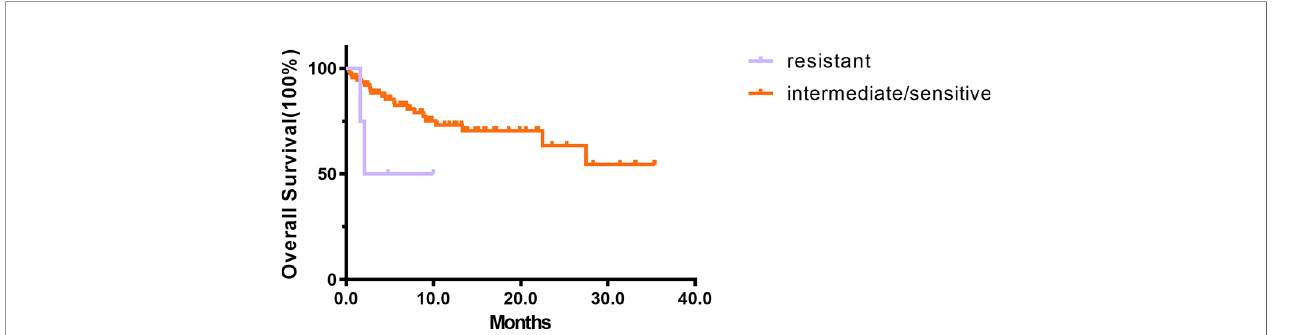
FIGURE 3 | The prognosis of 94 de novo AML. The results of Kaplan – Meier analyses for overall survival in intermediate/sensitive (Group 3 + 4 + 5) and resistant (Group 1 + 2)